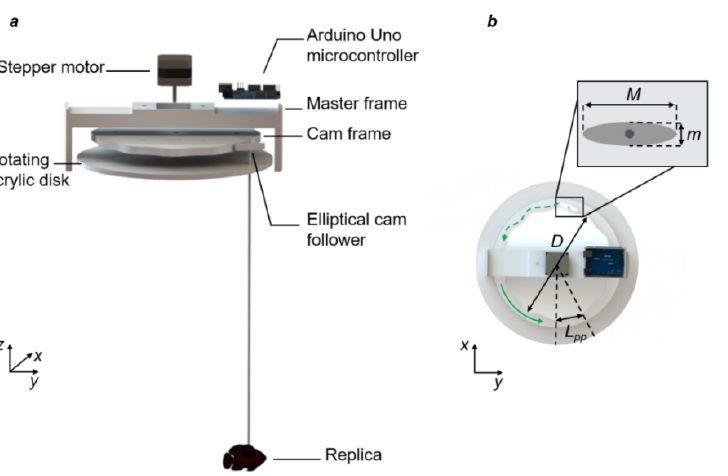
Figure 7 . Computer-aided design of the robotic platform to study fear response of zebrafish. (a) Exploded schematics and (b) illustration of the working principle of the robotic platform from a top view with a close-up of the elliptical cam follower. The trajectory of the replica is displayed as a dashed green line, while the motion of the rotating acrylic disk is shown as a solid green line. [Reproduced from (Neri et al.,